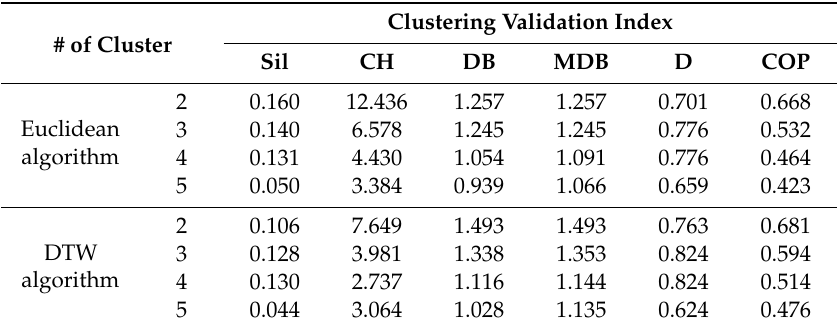
Table 4. Clustering Validation Index for the Euclidean and Dynamic Time Warping (DTW) Algorithms. Shading represents the largest value (DB, MDB, COP) or the smallest value (Sil, CH, D) of an index.